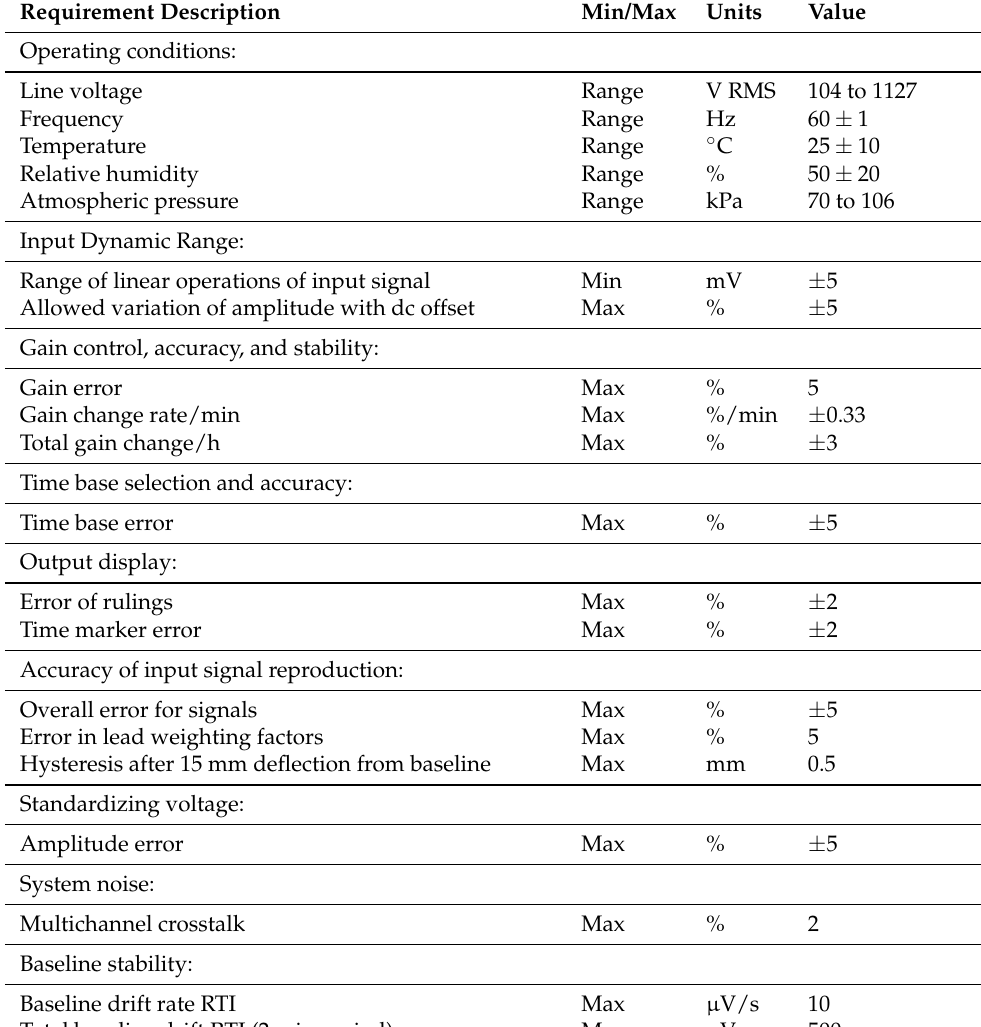
Table 1. Requirement of ECG monitoring devices and their description